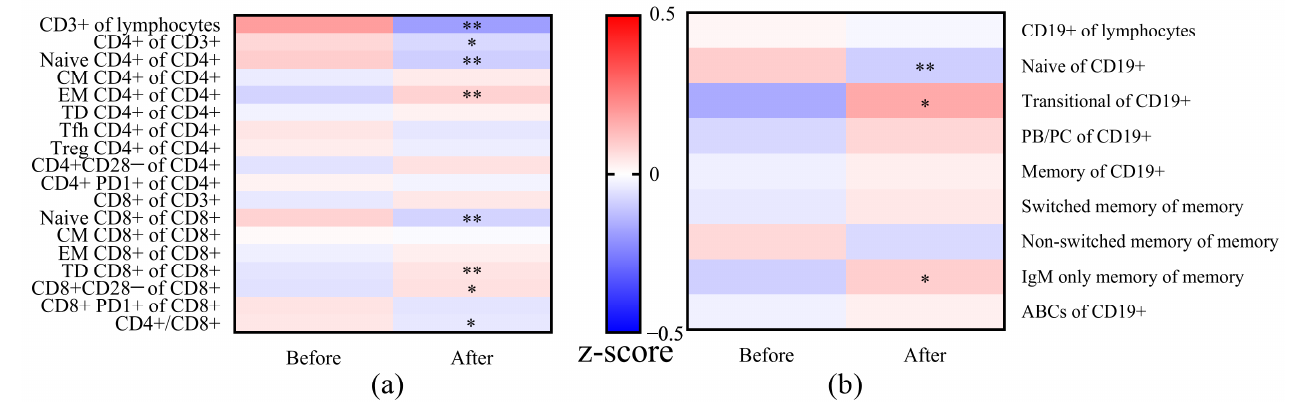
Figure 5. Comparison of frequencies of T ( a ) and B ( b ) cell subsets in patients before and after vaccination. The frequencies were normalized to z-scores, using the means and standard deviation per subset (values before and after vaccination as the total group). The normalized z-scores were displayed on a color scale, ranging from − 0.5 (blue means before vaccination or after vaccination lower than the means of the total) to 0.5 (red means before vaccination or after vaccination higher than the means of the total). The frequencies of T/B cell subsets were compared between before vaccination and after vaccination using the Wilcoxon signed-rank test. * p < 0.05 and ** p < 0.01. Abbreviations: CM, central memory; EM, effector memory; TD, terminally differentiated; Tfh, T follicular helper cells; Treg, regulatory T cell; PB/PC, plasma blast/plasma cell; ABCs, age associated B cells.